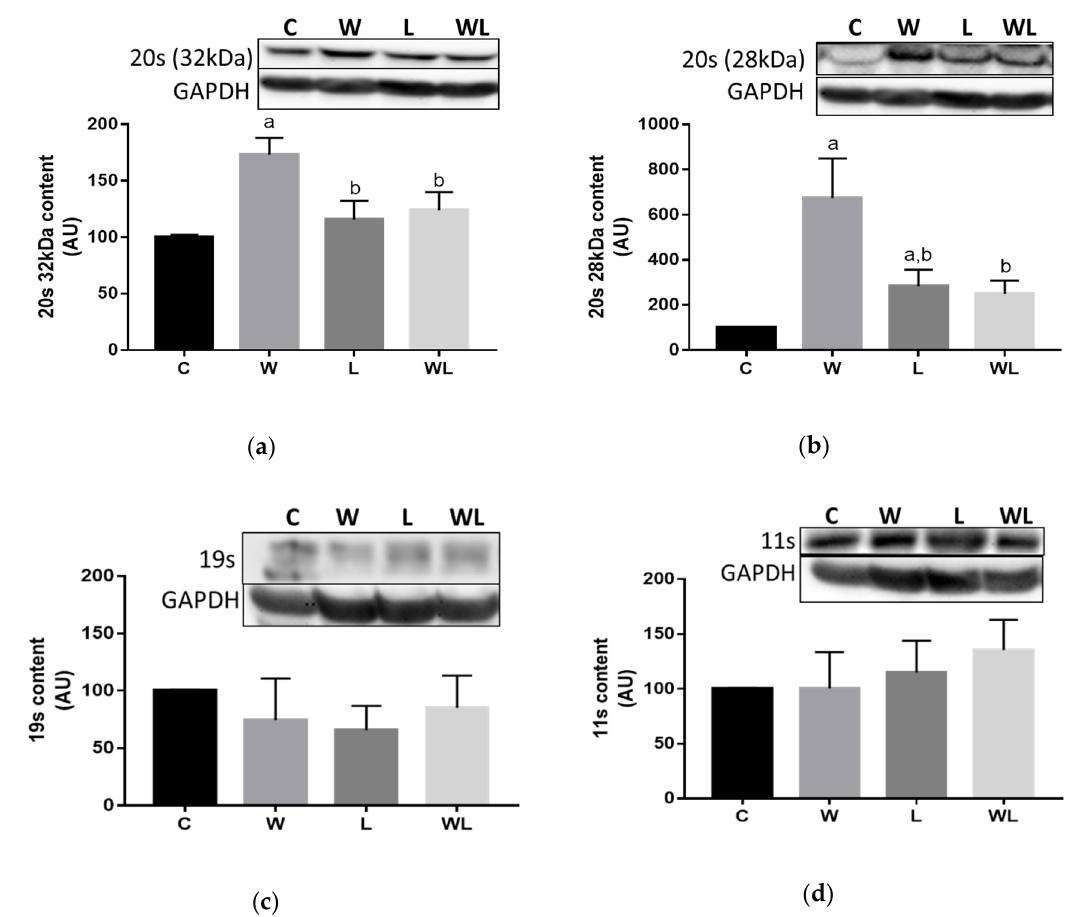
Figure 4. Tumour growth affected the ubiquitin-proteasome pathway. Proteasome subunits contents ( a ) 20S (32 kDa); ( b ) 20S (28 kDa); ( c ) 19S; and ( d ) 11S. The results represent bands that were quantified and normalised by GAPDH expression. Western blot images are representative of the total results obtained. Values are expressed as the relative percentage in the C group, which was set equal to 100%. C, Control; W, Tumour-bearing animals; L, Group without tumour with a maternal leucine-rich diet; WL, Tumour-bearing group with a maternal leucine-rich diet. n = 6, minimal animals per group. For details, see the Materials and Methods section. Values are presented as the mean ± SEM. The data were analysed using a two-way ANOVA followed by the Bonferroni test to evaluate comparisons among groups. a p < 0.05, for comparison with the C group; b p < 0.05, for comparison with the W group.